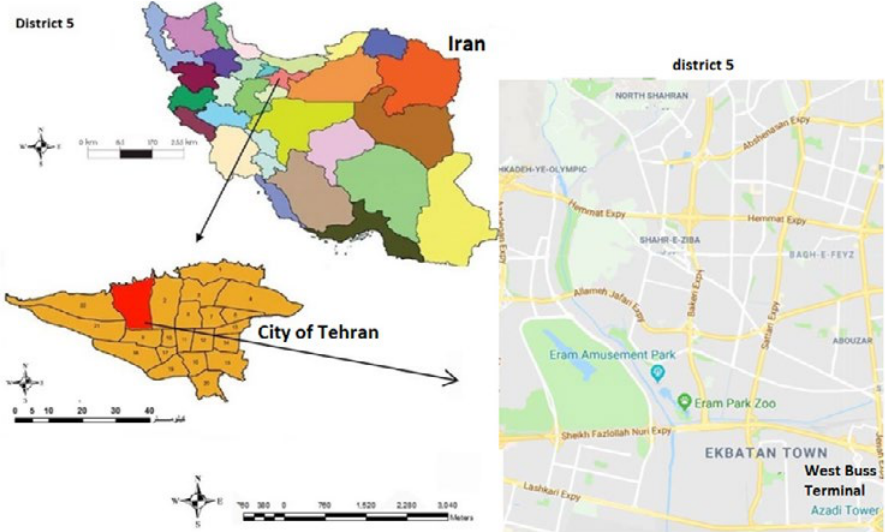
Fig. 1: Map of the study area